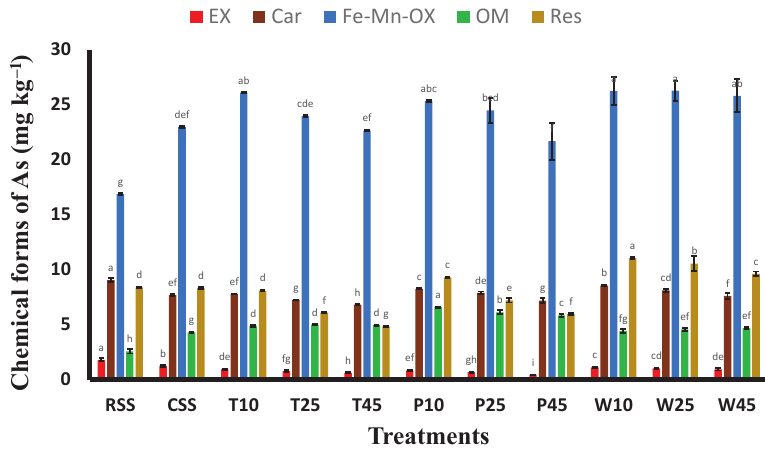
Figure 2: Chemical forms of As in RSS and produced compost samples. Different letters (in the same chemical forms of treatments) indicate significant differences among the mean of different treatments (p < 0.05). Error bars represent the standard deviation. (Each abbreviation in x-axis is defined in Table